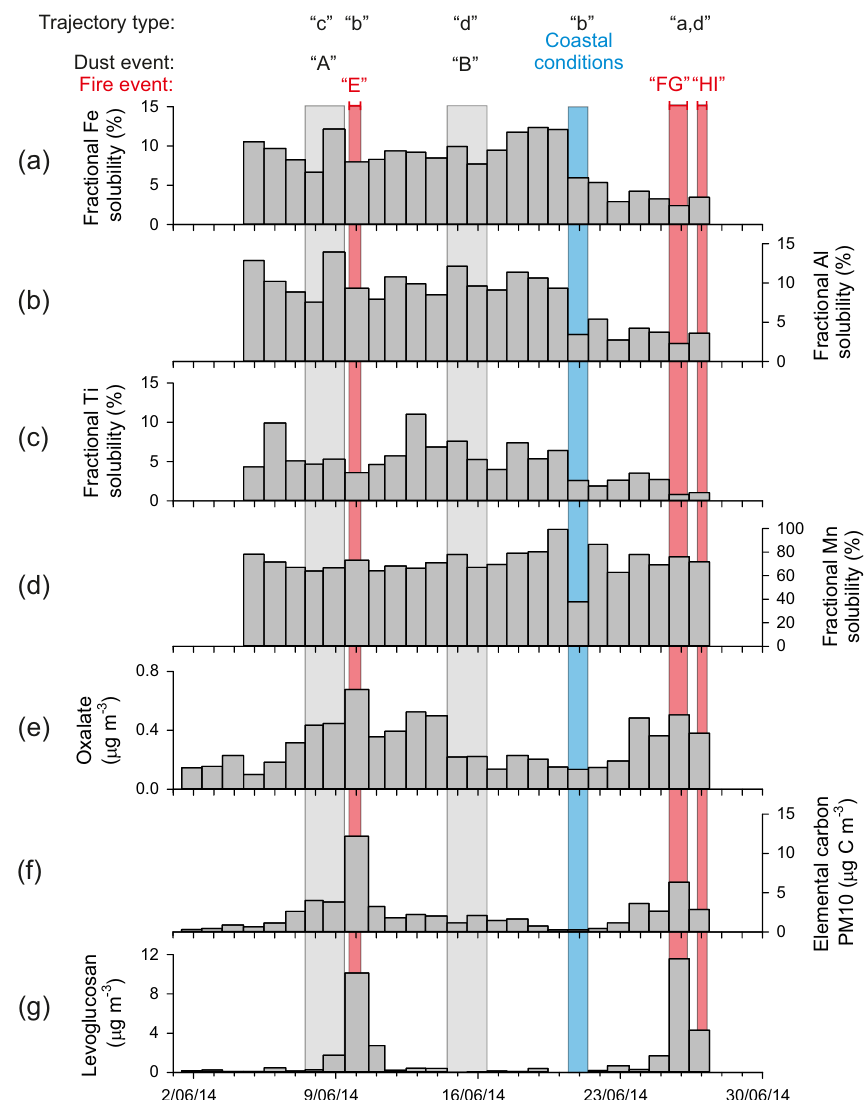
Figure 6. Composition of daily aerosol samples influenced by dry season biomass burning at Gunn Point, northern Australia. The time series highlights markers indicative of biomass burning and the associated trace metal fractional solubility (a) fractional Fe solubility, (b) fractional Al solubility, (c) fractional Ti solubility, (d) fractional Mn solubility, (e) oxalate concentration, (f) elemental carbon concentration, and (g) levoglucosan concentration. Fire events, dust events and coastal conditions are highlighted. For trajectory types associated with these periods refer to Fig.